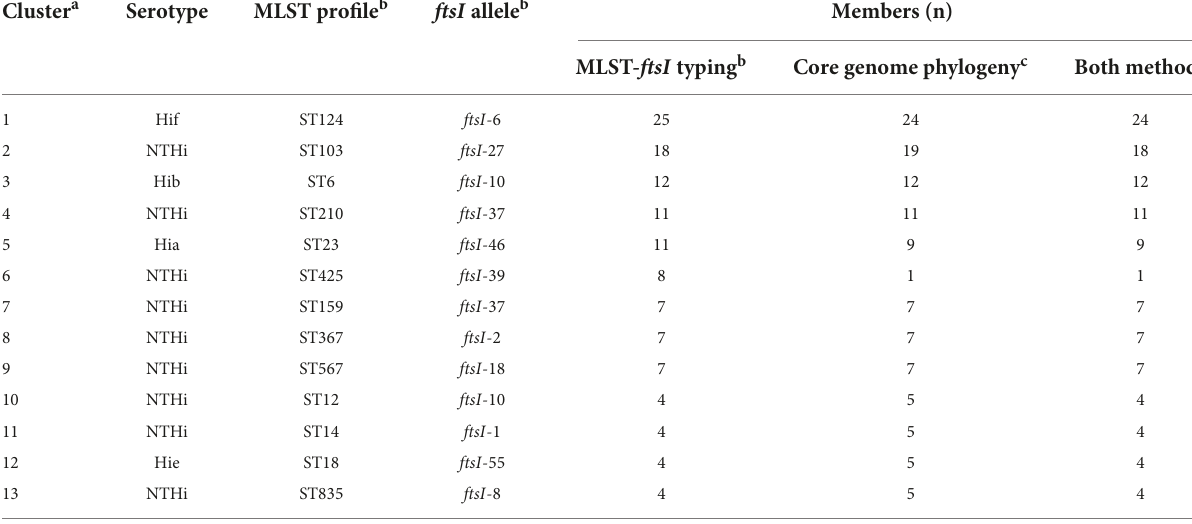
a Onlyclusterswithatleastfivememberswithatleastonemethodareshown. b UniquecombinationsofMLSTprofileand ftsI allele(MLST- ftsI typing)wereusedtodefineclones(Skaareetal.,2014a;Jolleyetal.,2018). c Cut-offforclusterdefinition:0.0010nucleotidesubstitutionspersite( Figure4B ).Bydefinition,clustersmaycompriseisolateswithdivergingMLST- ftsI types.